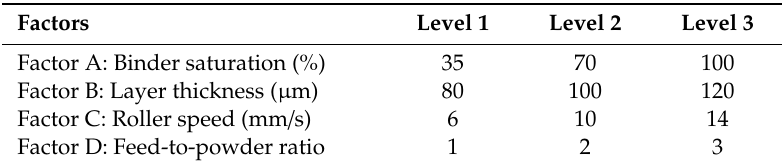
Table 16. Printing parameters at three levels [107].